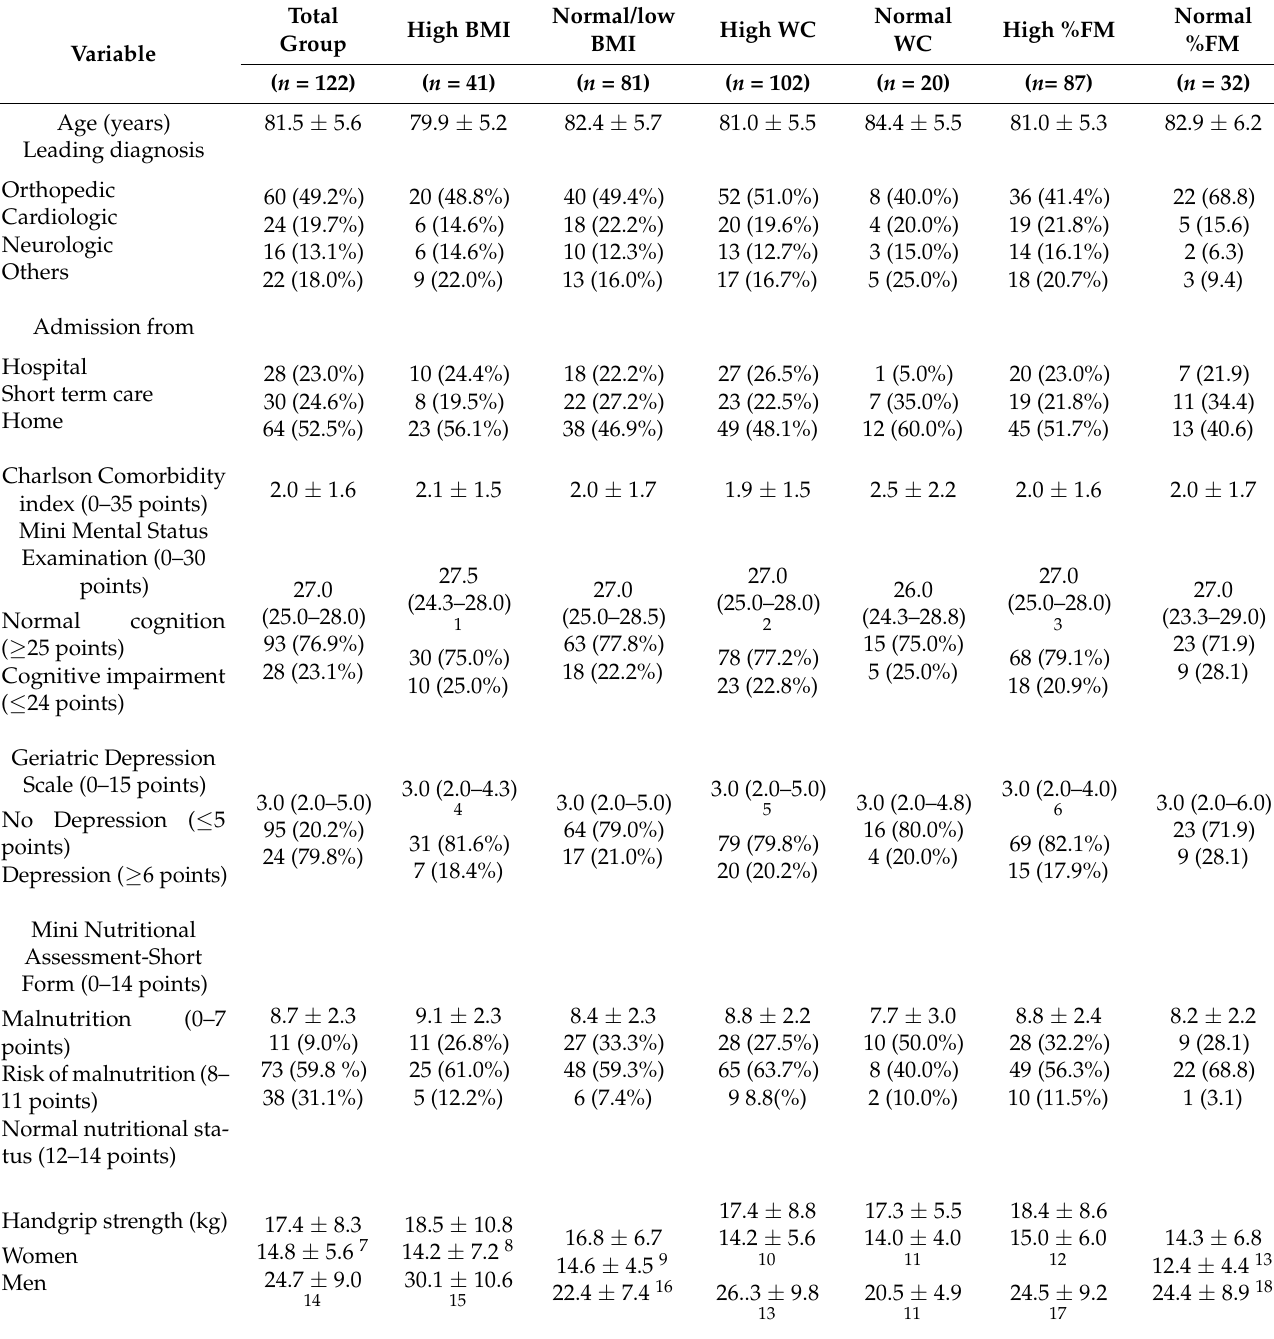
Table 1. Characteristics of geriatric rehabilitation patients according to groups of body mass index, waist circumference and percentage body fat mass at